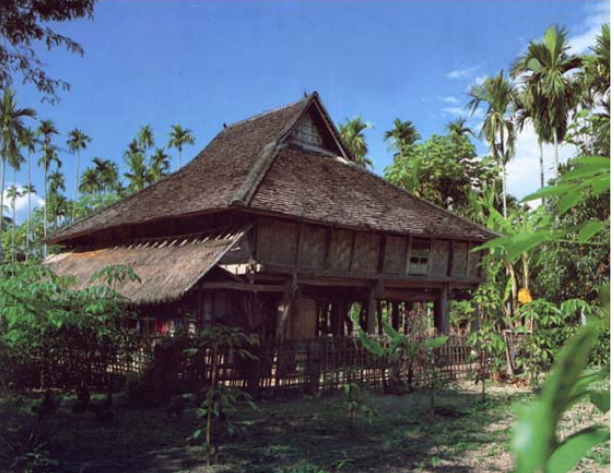
Figure 24. Photo of wooden storied house